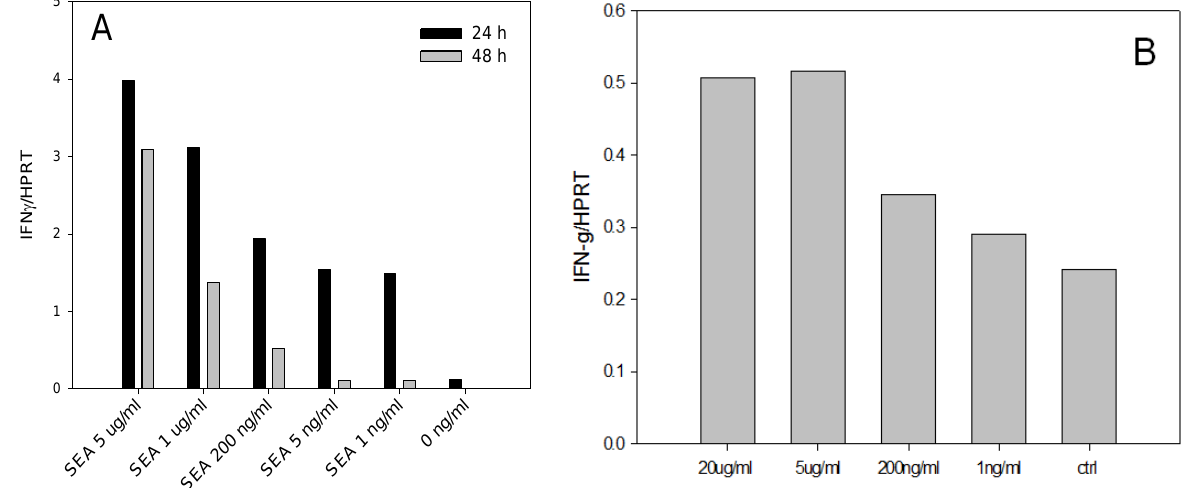
Figure 1. Biologically active SEA induces IFN-γ mRNA levels in dose dependent response. IFN-γ/HPRT mRNA ratio was measured after incubation of splenocytes for 24 and 48 h ( A ) or positively selected mouse naïve CD4 + T-cells for 24 h; ( B ) with decreasing concentrations of